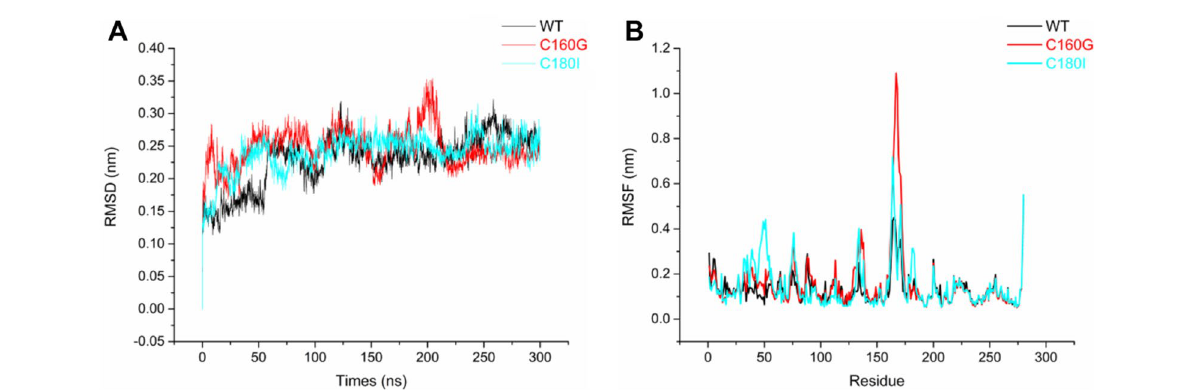
Fig. 7 Molecular dynamics simulations reveal the dynamic differences among WT and its mutants. A After 300 ns, all the proteins are in equilibrium with similar RMSD. B RMSF comparison shows that the loop region (residues 156–174) in C160G is most dynamics, and the region in WT is most